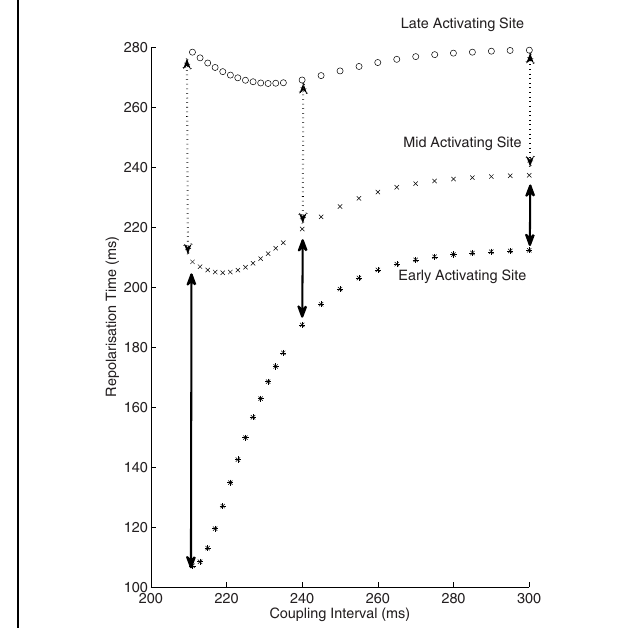
FIGURE 6 | Increase in dispersion of repolarization with reducing coupling intervals. Repolarization times from 3 sites are shown against coupling intervals. The early activating site can be considered to be equivalent to the stimulus site, and is not measured clinically due to artifact. This early site is exposed to only minimal activation time increase at short coupling intervals, thus the repolarization time is approximately equal to the ARI at this site. The mid and late activating sites do exhibit an increase in dispersion of repolarization (broken arrows), but this is minor in comparison to the increase from the early to mid site (solid arrows). Thus, there is a marked spatial increase in the repolarization gradient near the stimulus site following premature